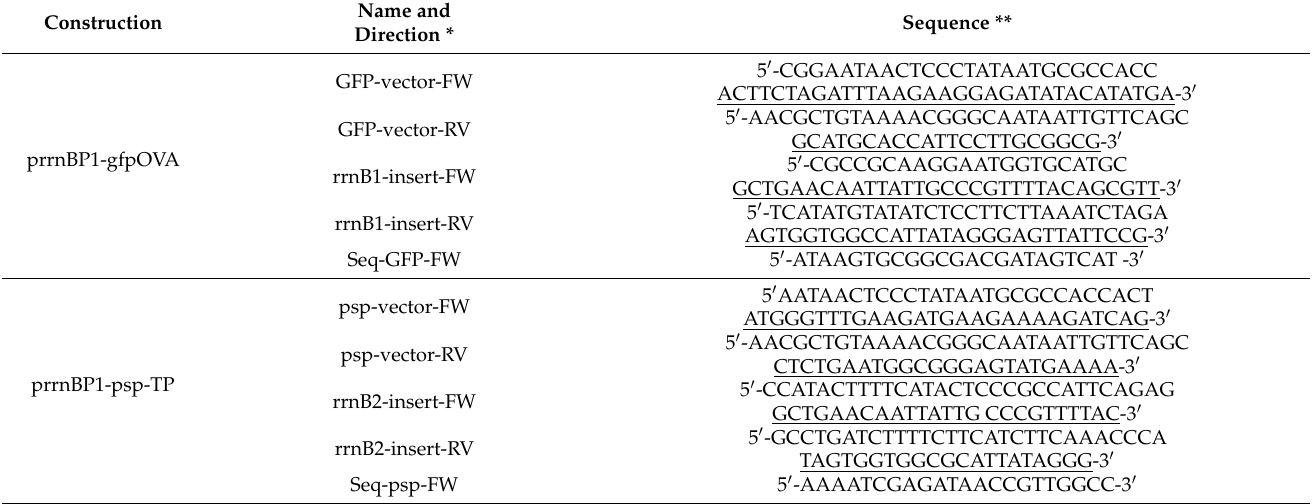
Table 2. Specific primer sequences for engineered